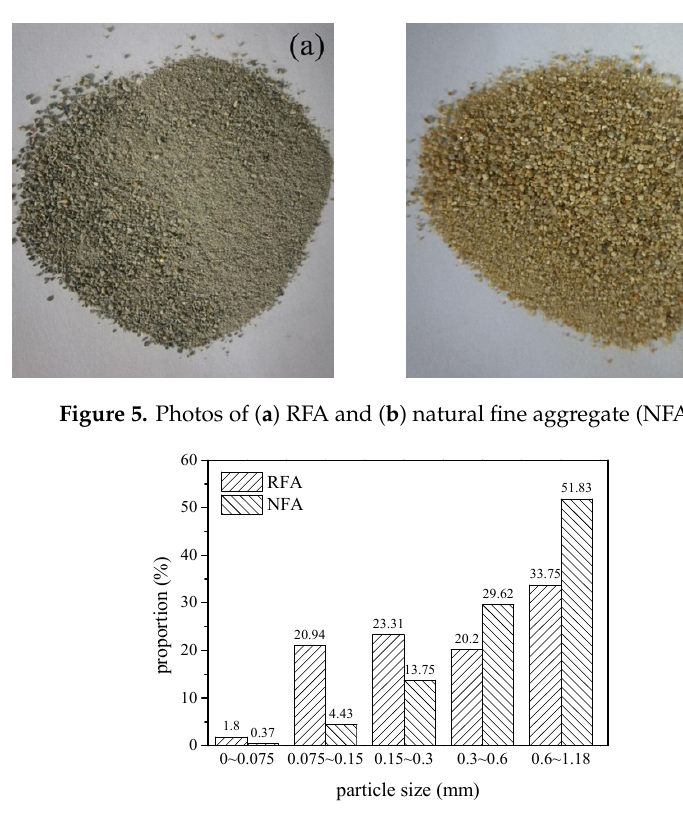
Figure 6. Particle size distribution of RFA and NFA.